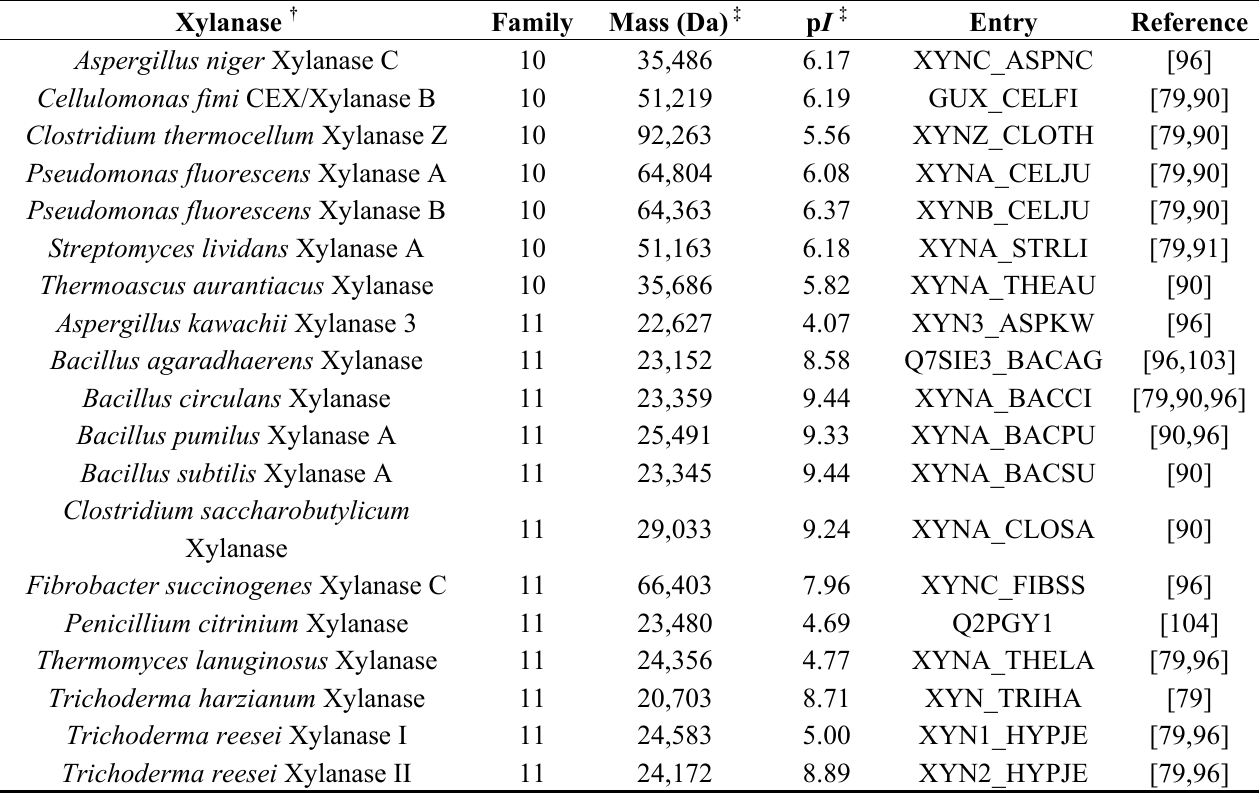
Table 2. Sample Distribution of Xylanases among Family 10 and Family